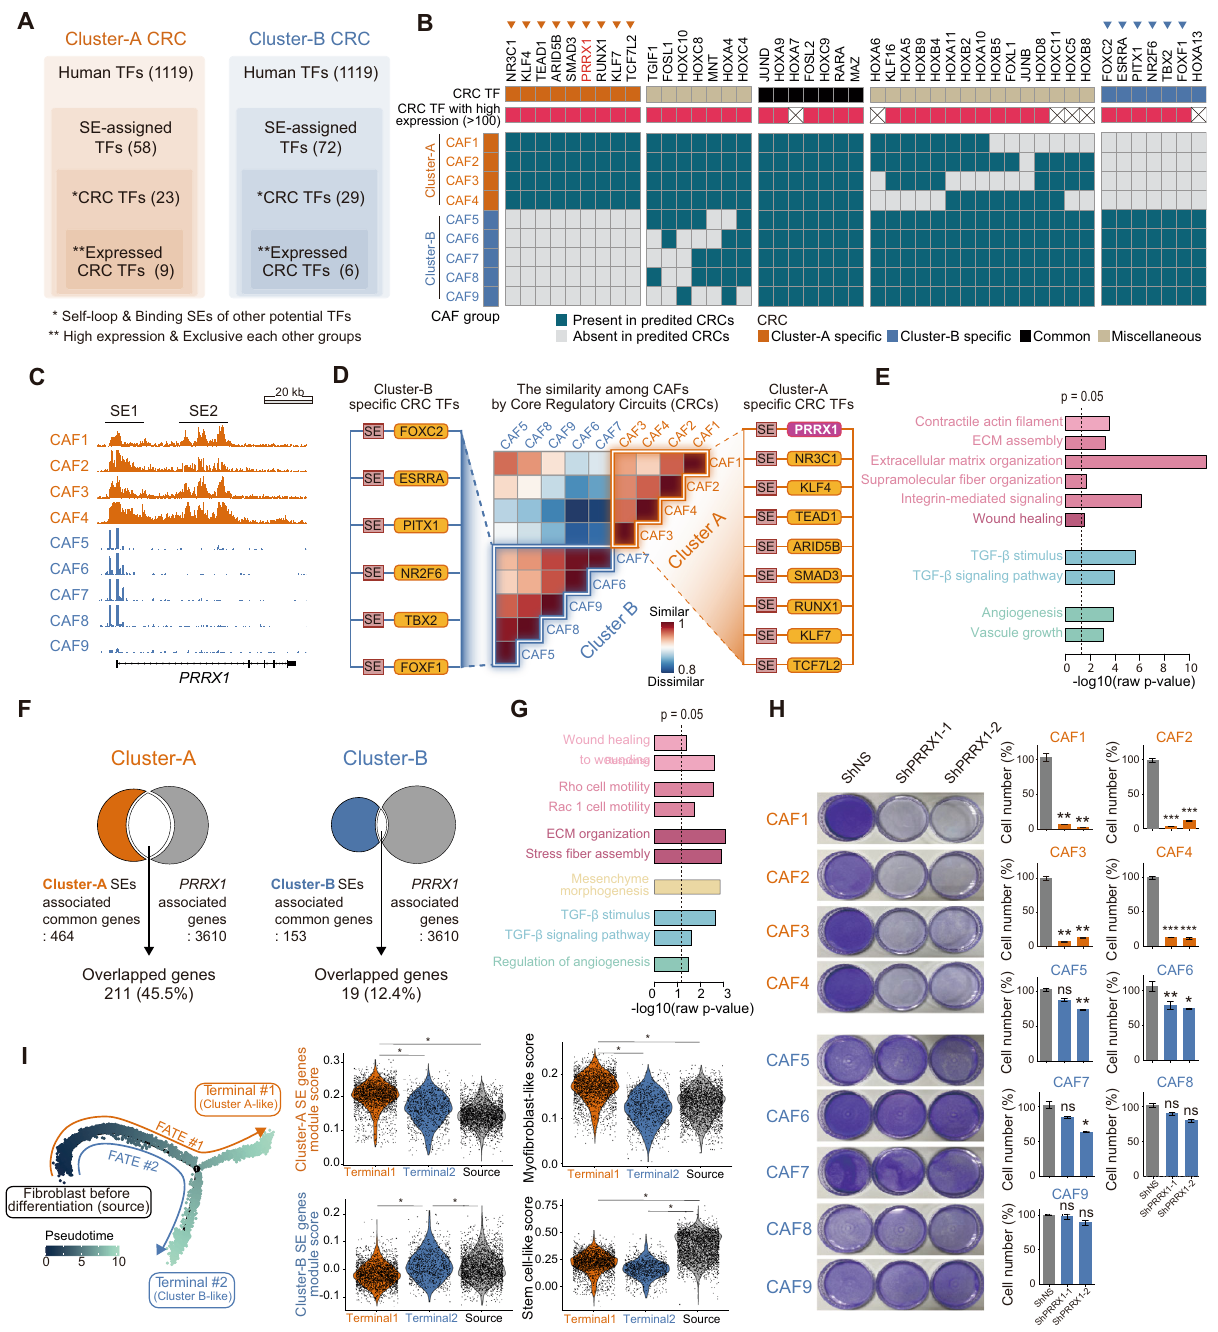
PCR genotyping . For genotyping PCR analysis, 1 – 2 mm sections of tail tip were dissolved in 0.5ml of 50 mM Tris (pH 8.0), 100 mM EDTA, 0.5% SDS, and 0.5mg/ ml proteinase K (Roche) solution at 55 °C for at least one hour with vigorous shaking. The DNA was puri fi ed by Isopropanol followed by ethanol precipitation and then dissolved in 0.5ml of Ultrapure water. The Collagen Type 1 alpha-rtTA and Prrx1-tetO7-luc transgenic lines were screened as described previously. The Prrx1-tetO7-luc line was detected with the following primers: mPrrx1-Luc3-F 5 ′ - GGCCAACAGCATTGCC-3 ′ and mPrrx1-Luc3-R 5 ′ - GAGCCTGGACCACTG-3 ′ . The Collagen Type 1 alpha-rtTA line was detected with the following primers: SV40_F1 5 ′ - GGTTACAAATAAAGCAATAGCATCAC-3 ′ Col1a2_R2 5 ′ - CAGCAGGAGGTTTCGACTAAG-3 ′ . DNA was ampli fi ed using PCR and PCR products were resolved on a 2% agarose gel. Co-injection model . 168FARN-Luc-GFP mouse cancer cells 1 × 10 5 were injected subcutaneously in the left inguinal region of each NOD/SCID mouse. Where indicated, 168FARN 1 × 10 5 cells were mixed with 3 × 10 5 WT (SgNS) or